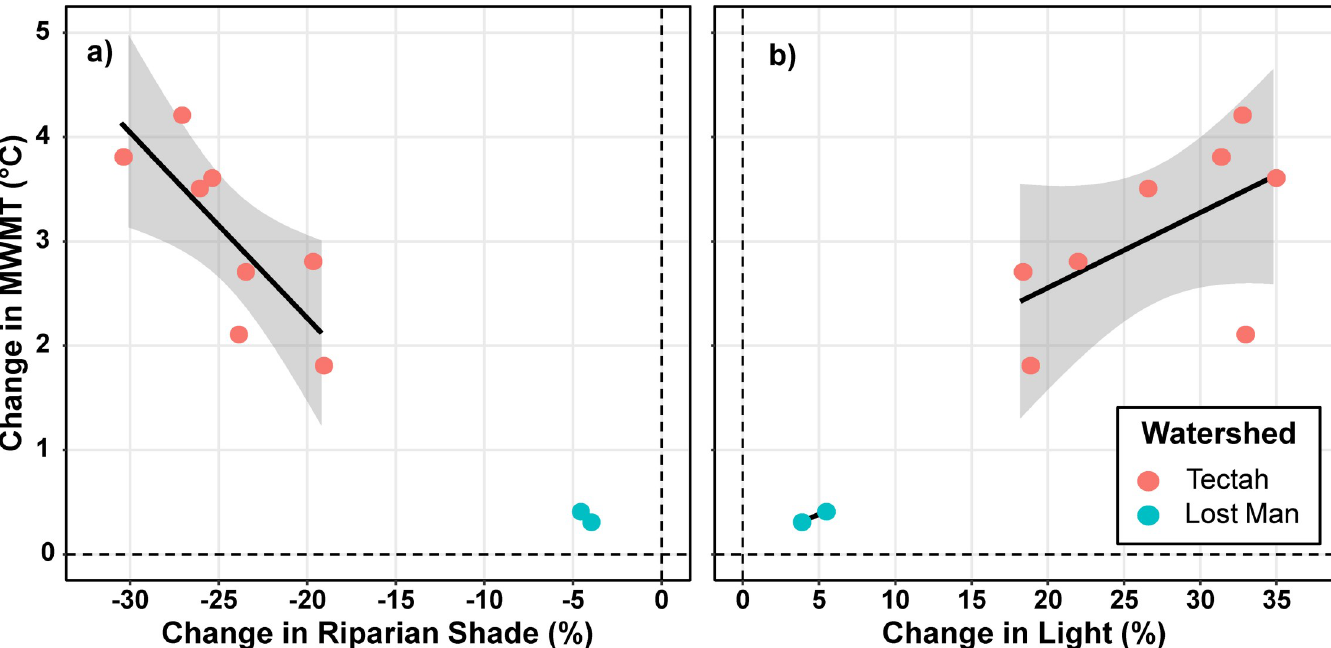
Fig 6. Relationships between shade, light, and stream temperature. Relationships between the responses of riparian shade (a) and light (b) and stream temperature (summer MWMT) associated with riparian thinning treatments in Tectah and Lost Man watersheds in northern California second-growth redwood forests. Responses are calculated as BACI differences. Gray shading indicates 95% confidence